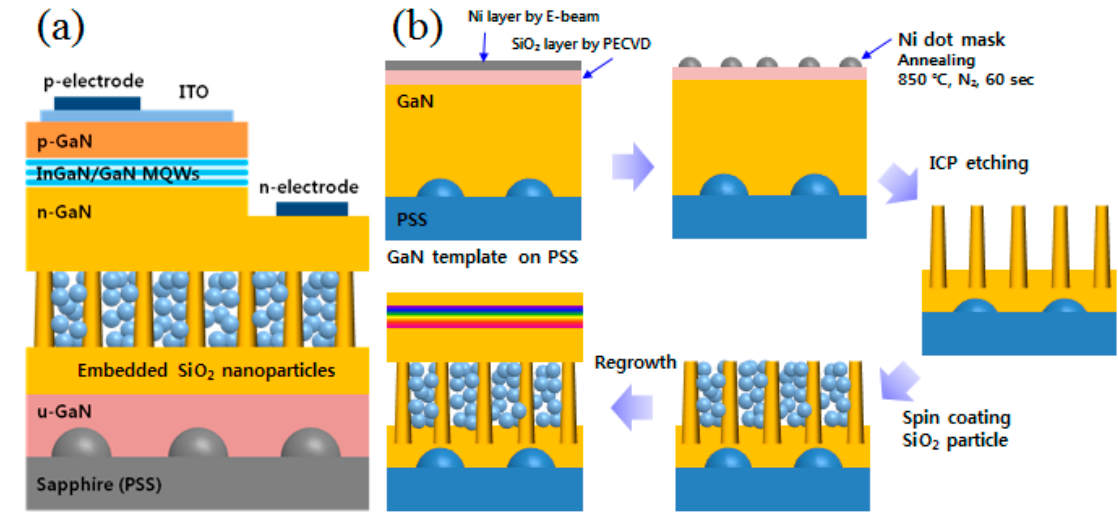
Figure 1. ( a ) GaN light emitting diode (LED) structure consisting of nano ‐ pillars and air ‐ void filled with SiO 2 nano ‐ particles (NPs) formed on patterned sapphire substrate (PSS). ( b ) Schematic illustration of the process flow to use Ni dots as a mask to form nano ‐ pillars and fill air ‐ void with SiO 2 NPs, and regrow GaN. ICP: inductively coupled plasma; MQW: multi quantum well.